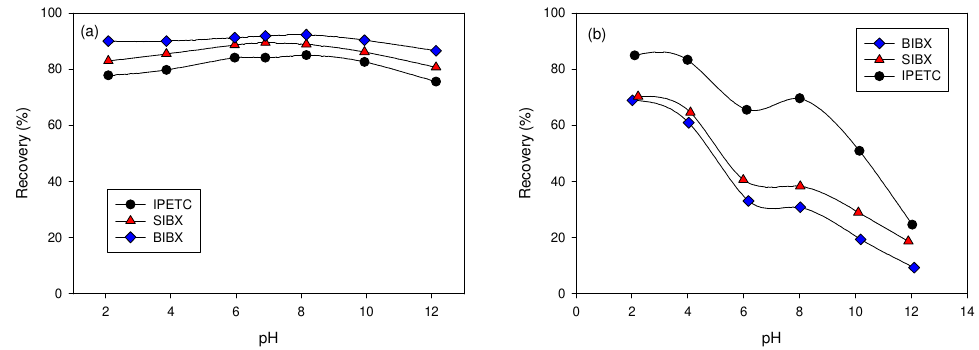
Figure 29. Recovery of pure chalcopyrite ( a ) and pyrite ( b ) as a function of pulp pH (collector concentration is 4 × 10 –5 mol · L − 1 ) (adapted from Ma et al. [126]).